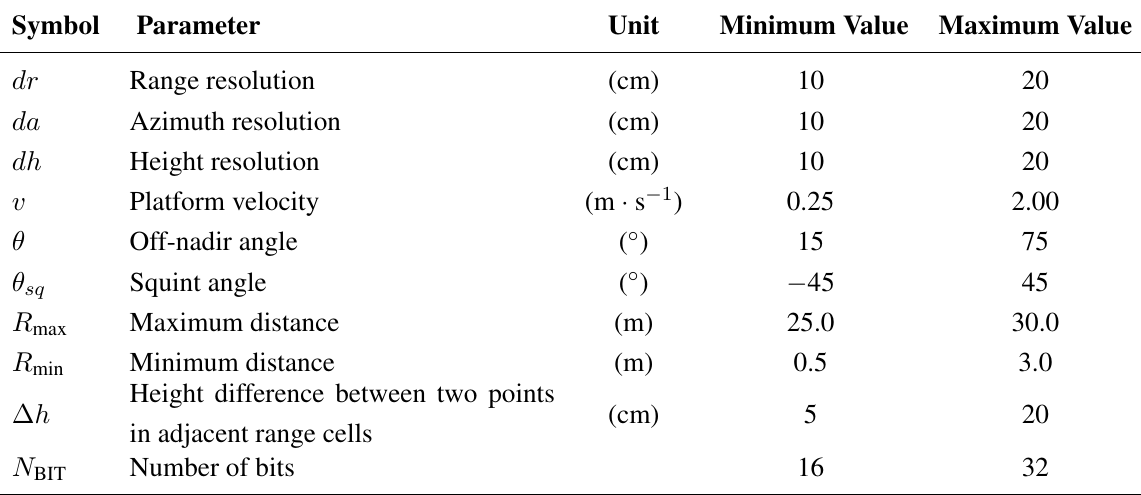
Table 3. Input parameters for the system